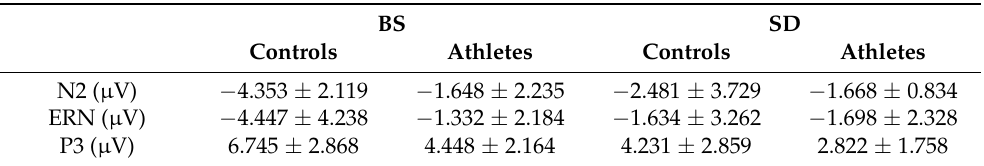
Figure 5. Grand mean ERP amplitude of table tennis athletes and controls on N2 in baseline state (BS) and 36 h sleep deprivation (SD) conditions. The data were averaged from Fz, FCz, and Cz. The topographies correspond to average activity in the time windows (190–250 ms, indicated by the gray bar) around the local peaks. Table 3. Means and standard deviations of ERP amplitudes’ means listed for all conditions (BS_Controls, BS_Table tennis athletes, SD_Controls, SD_Table tennis